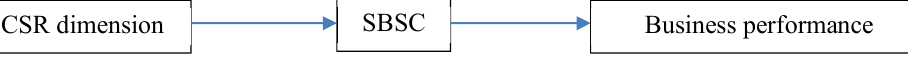
Fig. 3. Relationship between CSR, SBSC and business